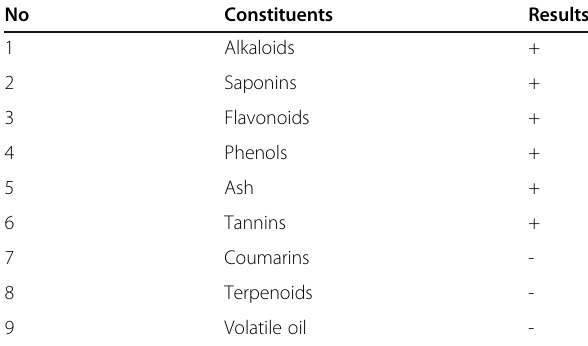
Table 1 Preliminary phytochemical constituents of the leaves M. verticillata